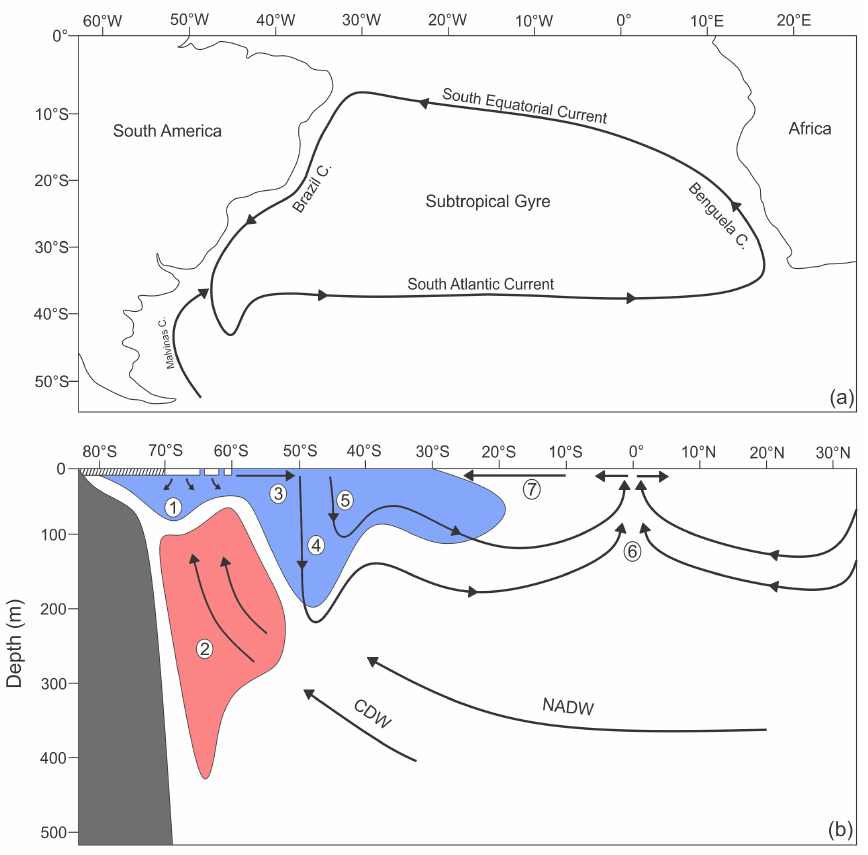
Figure 5. Schematic of the main changes in Southern Ocean and of how the cold and fresh water pulse from Antarctic sea ice melting has transferred towards the Tropical Atlantic